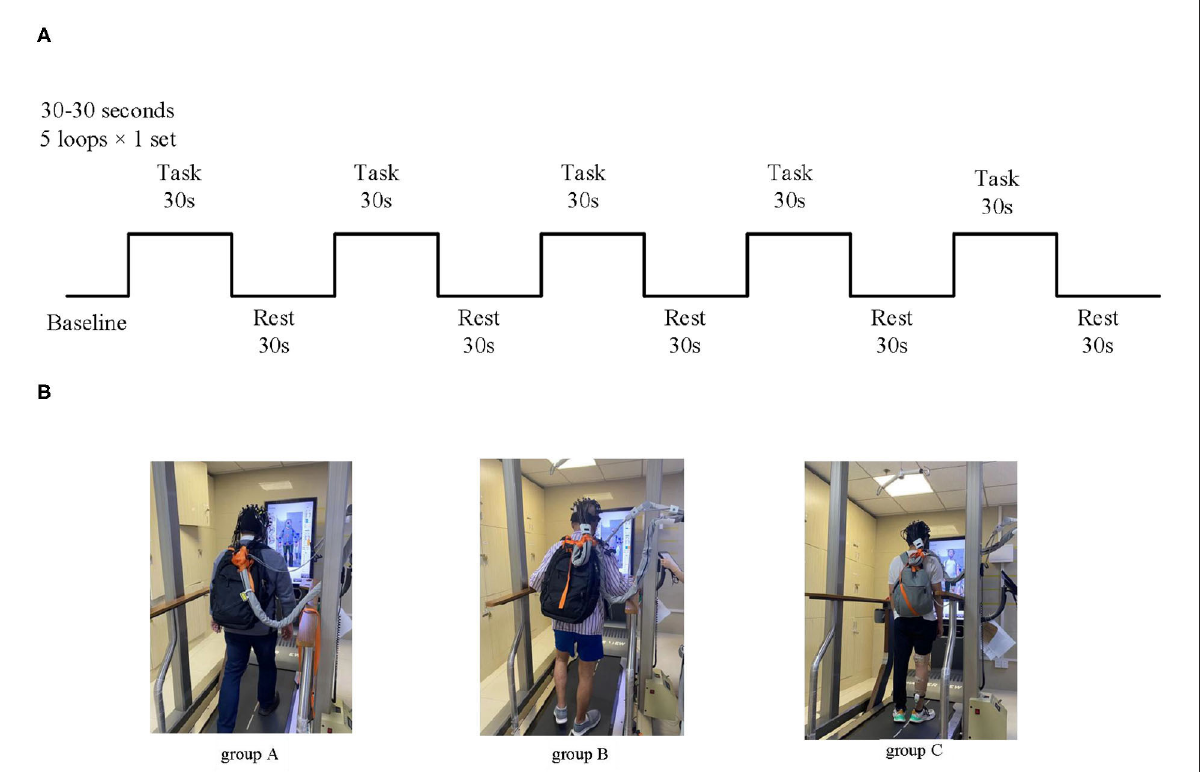
FIGURE2 Experimental block design for walking modes at a consistent speed. (A) Treadmill walking and FES-assisted walking modes. (B) Schematic diagram of experimental grouping; Group A: healthy treadmill walking at a speed of 2km/h; group B: hemiplegic treadmill walking at a speed of 2km/h; and group C: hemiplegic treadmill walking with FES assistance at a speed of 2km/h.